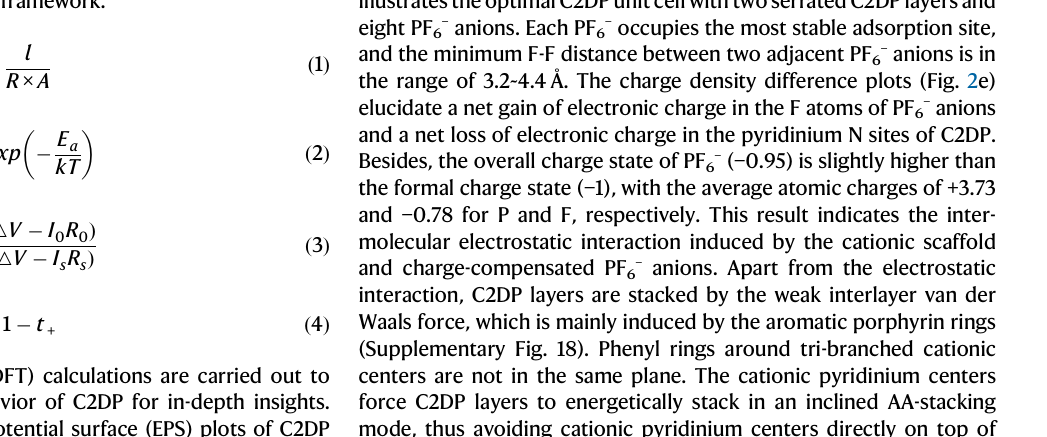
Fig. 2 | Rate capability and PF 6 − diffusivity. a Rate performance of the graphite electrodeand the C2DP-G electrode. b Log( σ )asafunctionof T − 1 forPP and C2DP- PP. c EPS plots of C2DP (isosurface value=0.005eÅ − 3 ). The blue and red colours denote de fi cient and rich electron density, respectively. d Simulated structureand